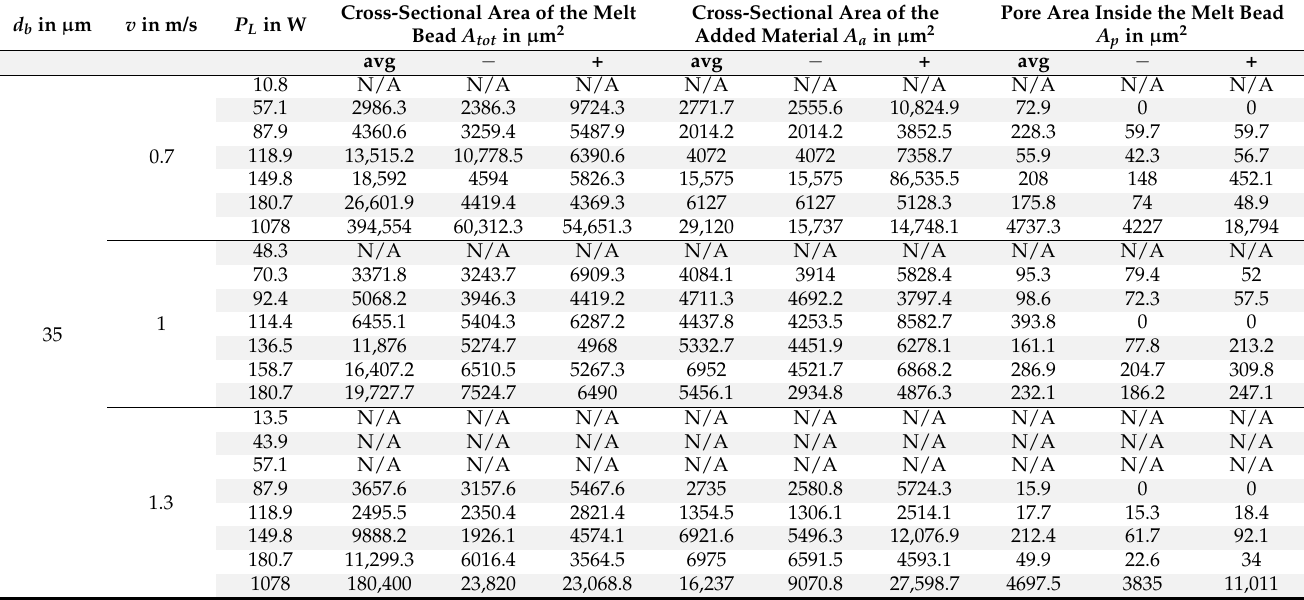
Table A1. Experimental plan and detailed results of the cross-sectional areas of the investigation. Each parameter set was repeated three times and at least six melt beads were analyzed per parameter